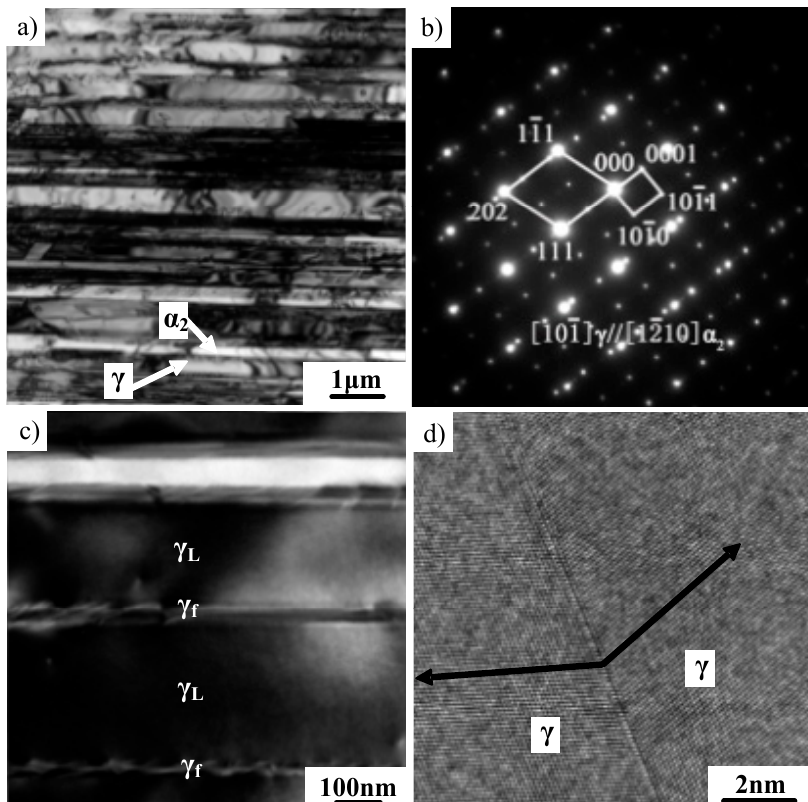
Figure 3. TEM images showing the microstructure of Ti–43Al–2Cr–2Mn–0.2Y alloy with a specific lamellar orientation. ( a ) γ / α 2 lamellae, ( b ) selected area electron diffraction (SAED) patterns of γ / α 2 lamellae, ( c ) γ / γ lamellae, ( d ) high-resolution image of the γ / γ interface.